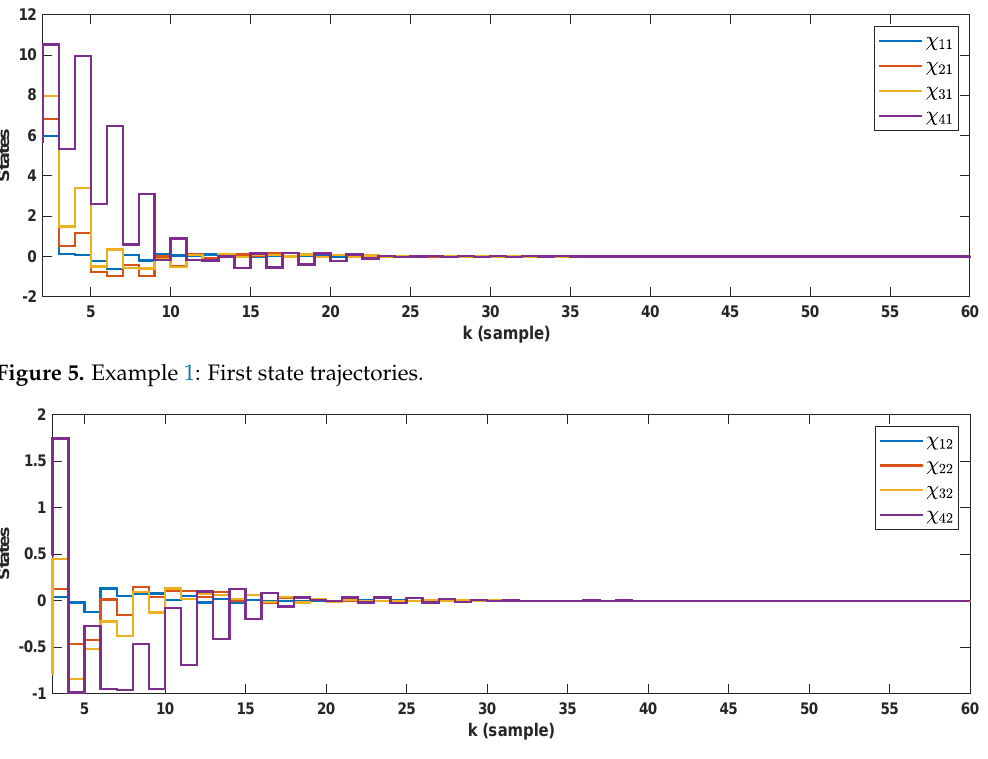
Figure 6. Example 1: Second state